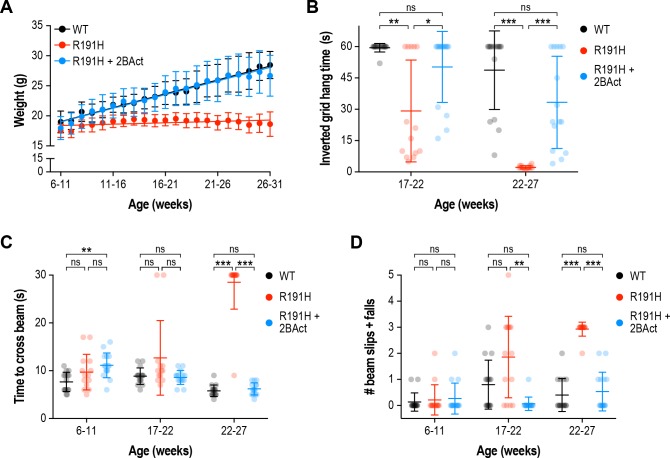
2BAct normalized body weight gain and prevented motor deficits in female R191H mice.(A) Body weight measurements along the study. Lines are linear regressions. At the 6–11 week time point when 2BAct treatment was initiated, body weights were not significantly different between the three conditions (p>0.05; two-way ANOVA with Holm-Sidak pairwise comparisons). R191H body weight was significantly lower at all subsequent time points. The body weights of 2BAct-treated R191H females were not significantly different from WT at any time point. (B) Inverted grid test of muscle strength. Time spent hanging was measured up to a maximum of 60 s. (C–D) Beam-crossing assay to measure balance and motor coordination. Time to cross the beam was measured up to a maximum of 30 s (C), and the number of foot slips/falls was counted (D). For all panels, N = 15 (WT), 14 (R191H) and 15 (R191H + 2 BAct) females were analyzed. Error bars are SD. For (B)-(D), *p<0.05; **p<0.01; ***p<10-3; nsp>0.05 by Mann-Whitney test with Bonferroni correction.